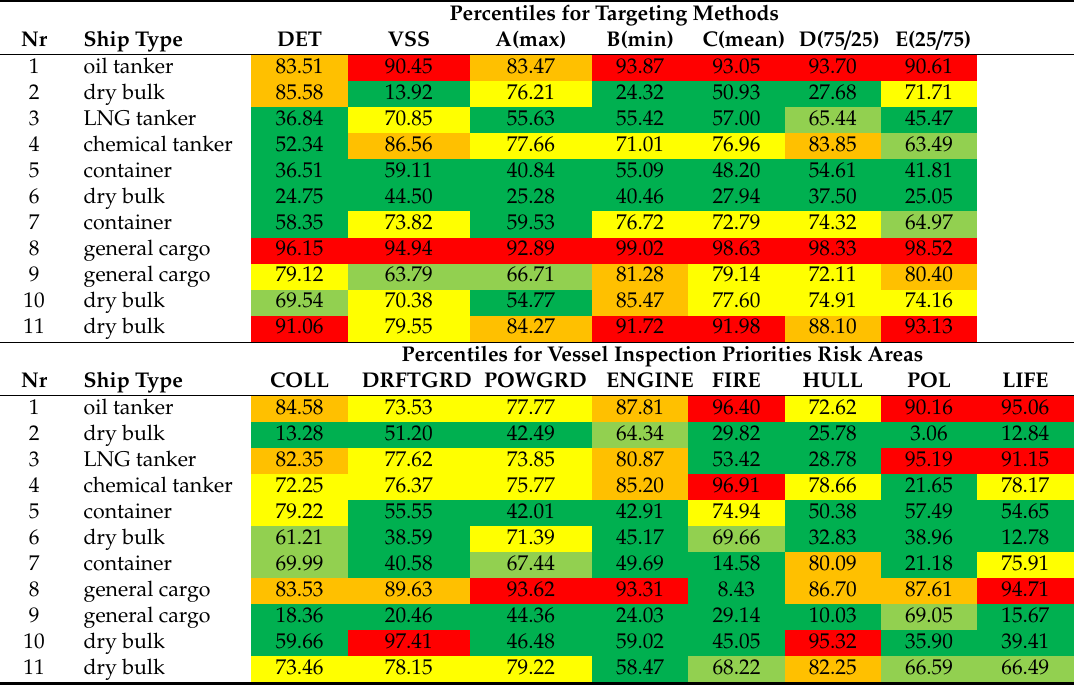
Table 8. Summary of percentile ranks of vessels in